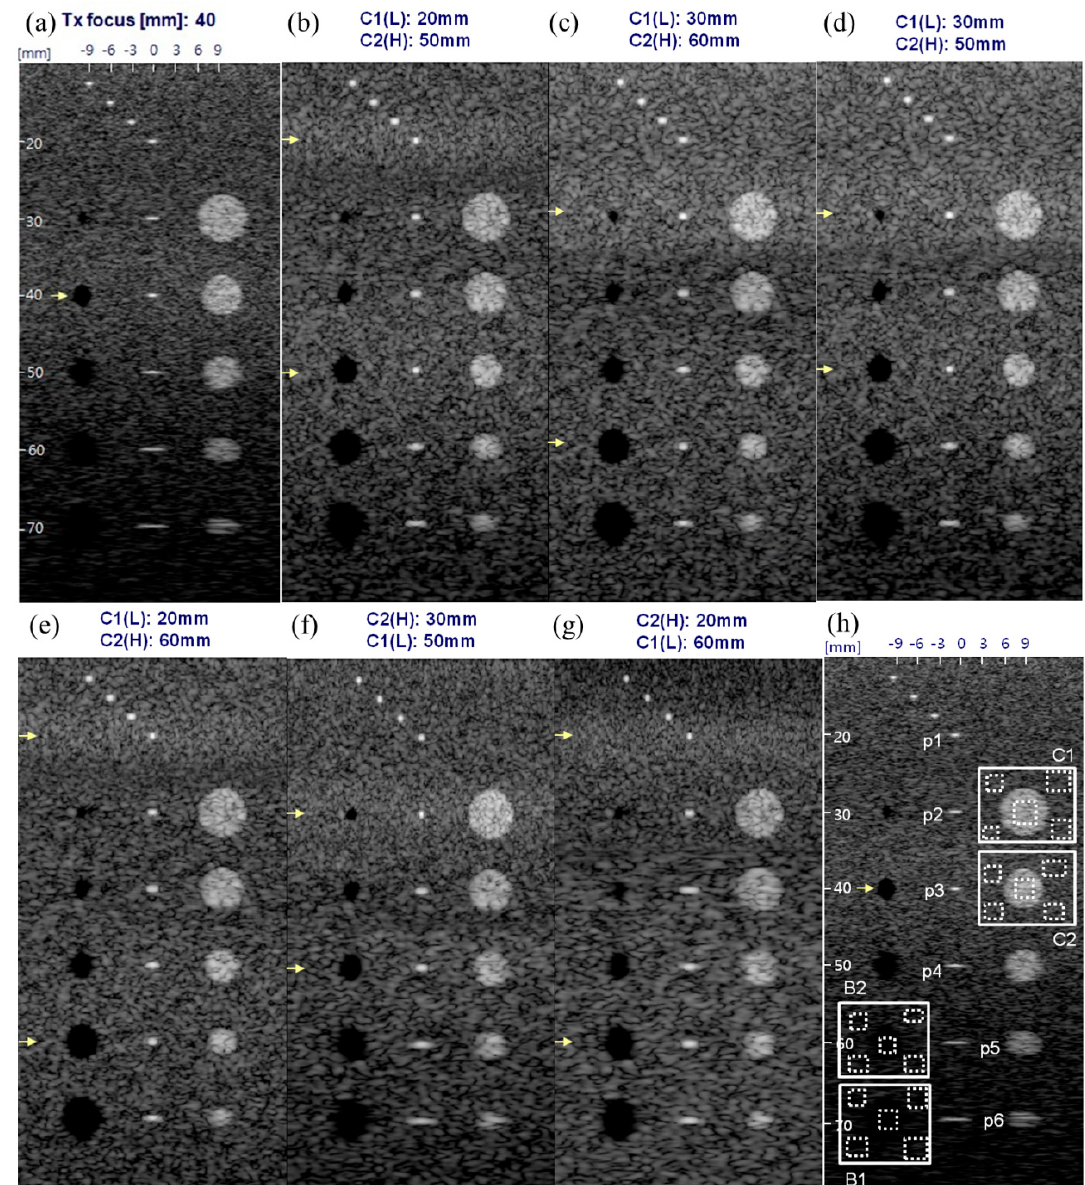
Figure 10. Computer generated B-mode images using a tissue mimicking phantom model (dynamic range: 60 dB). ( a ) The SF method: Tx focused at 40 mm, and STMF methods: Tx focused at ( b ) 20 mm for c 1 ( t ) (lower frequency chirp) and 50 mm for c 2 ( t ) (higher frequency chirp); ( c ) 30 mm for c 1 ( t ) and 60 mm for c 2 ( t ) ; ( d ) 30 mm for c 1 ( t ) and 50 mm for c 2 ( t ) ; ( e ) 20 mm for c 1 ( t ) and 60 mm for c 2 ( t ) ; ( f ) 30 mm for c 2 ( t ) and 50 mm for c 1 ( t ) ; and ( g ) 20 mm for c 2 ( t ) and 60 mm for c 1 ( t ) ; ( h ) marks of point targets (P1~P6), black holes (B1, B2) for hypoechoic targets and masses (C1, C2) for hyperechoic targets for quantitative evaluation using the tissue phantom model.